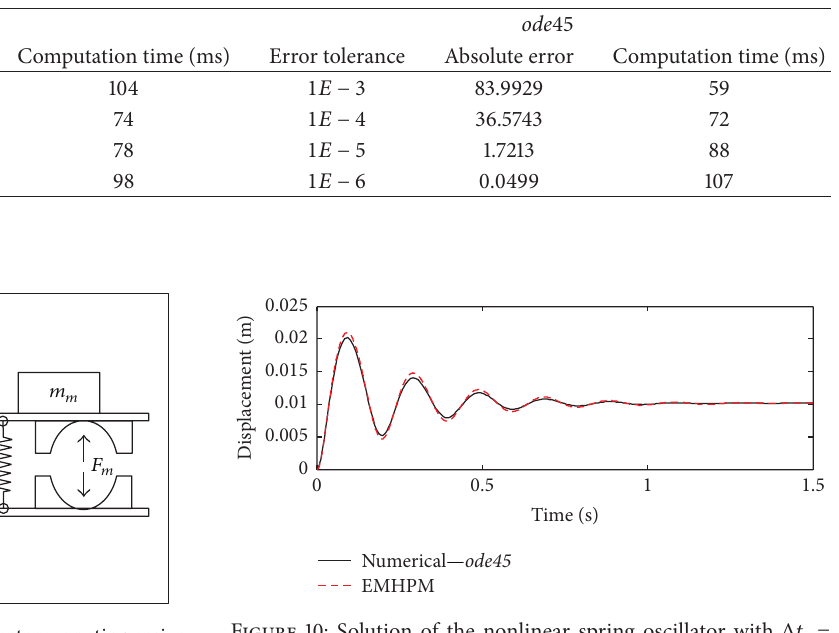
Figure 9: Nonlinear spring oscillator, right: elastomagnetic passive suspension.